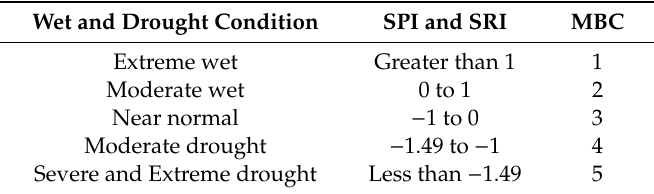
Table 1. Classification of wet and drought condition based on the Standardized Precipitation Index (SPI), Standardized Runo ff Index (SRI), and Markov Bayesian Classifier (MBC). Wet and Drought Condition SPI and SRI MBC Extreme wet Greater than 1 1 Moderate wet 0 to 1 Near normal − 1 to 0 Moderate drought Severe and Extreme drought Less than − 1.49